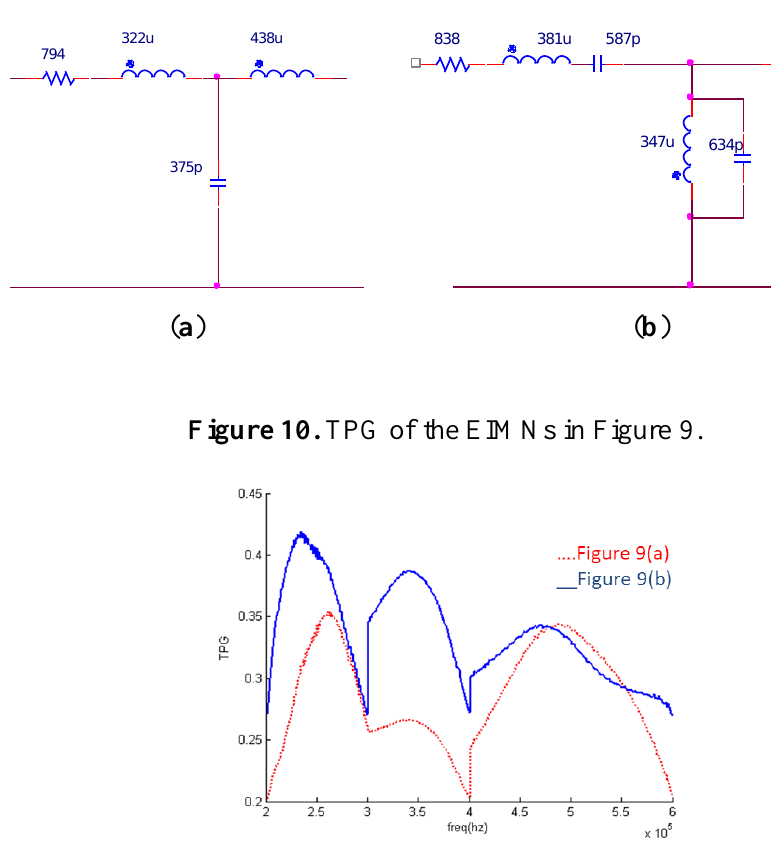
Figure 9. Results of two algorithms: ( a ) RFT; ( b ) algorithm introduced in Section 2.